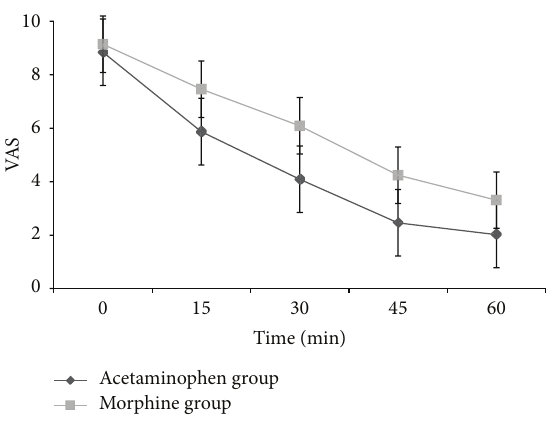
Figure 2: Comparison of visual analogue scores (VAS) between the acetaminophen and the morphine group before and 15, 30, 45, and 60 minutes after drug